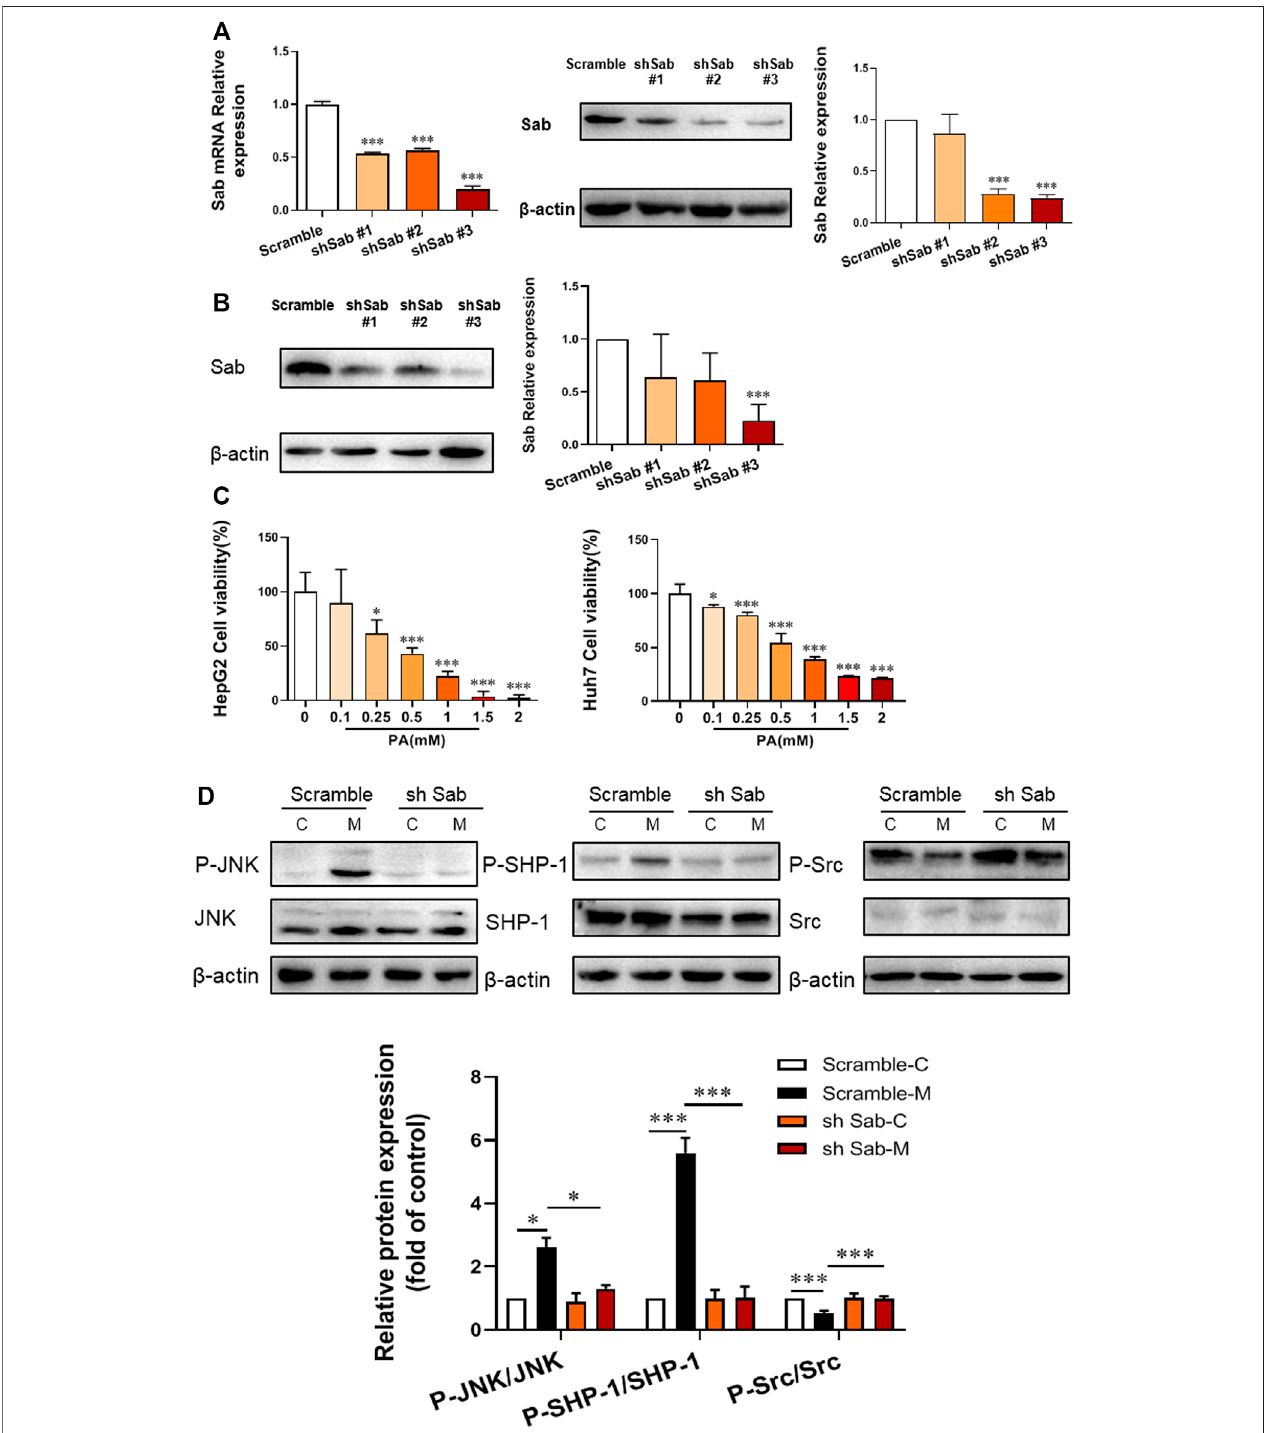
FIGURE 1 | Sab knockdown inhibited PA-induced activation of JNK/Sab signaling pathway in hepatocytes. (A) The mRNA and protein expression level of Sab in HepG2 cells transfected with Sab shRNA lentivirus or scramble. *** p < 0.001 vs. Scramble. (B) The protein expression level of Sab in Huh7 cells with Sab shRNA lentivirus or scramble. *** p < 0.001 vs. Scramble. (C) The effect of different concentrations of PA on cell viability. * p < 0.05, *** p < 0.001 vs. PA 0 mM group. (D) The expression and activation level of JNK, SHP-1, and Src protein in HepG2 cells with PA induction (Model) or without (Control). * p < 0.05, *** p < 0.001. n = 3.